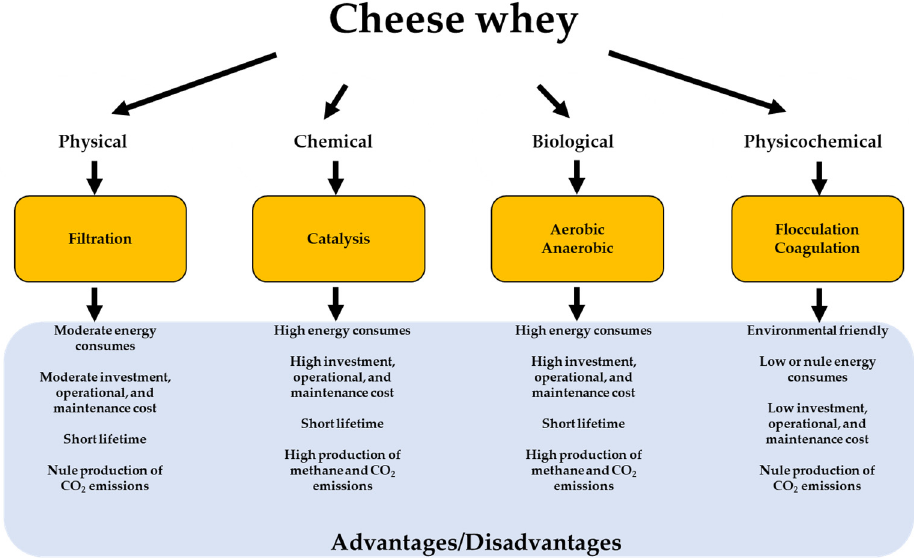
Figure 2. Conventional process to treat cheese whey.